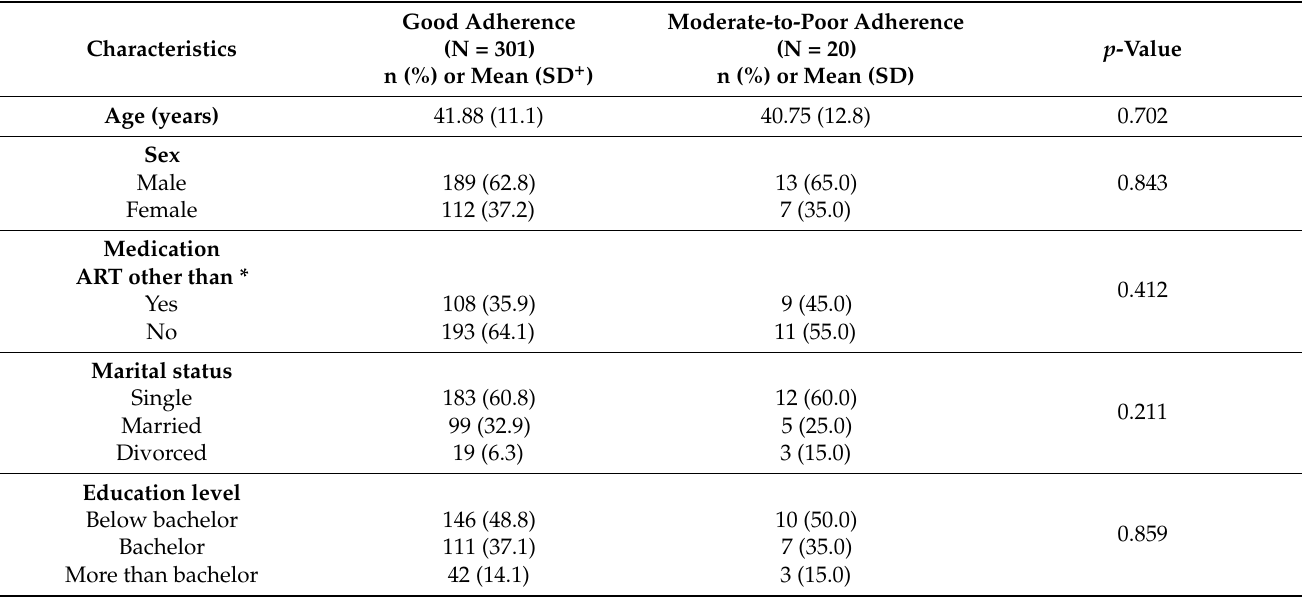
Table 1. Baseline characteristics of Thai travellers living with